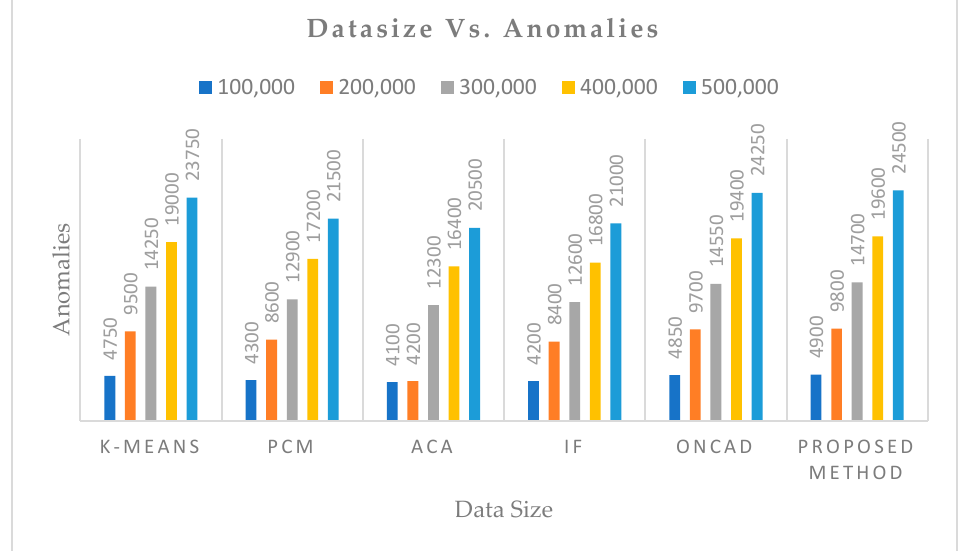
Figure 4. Comparative analysis of anomalies using KDDCUP’99.